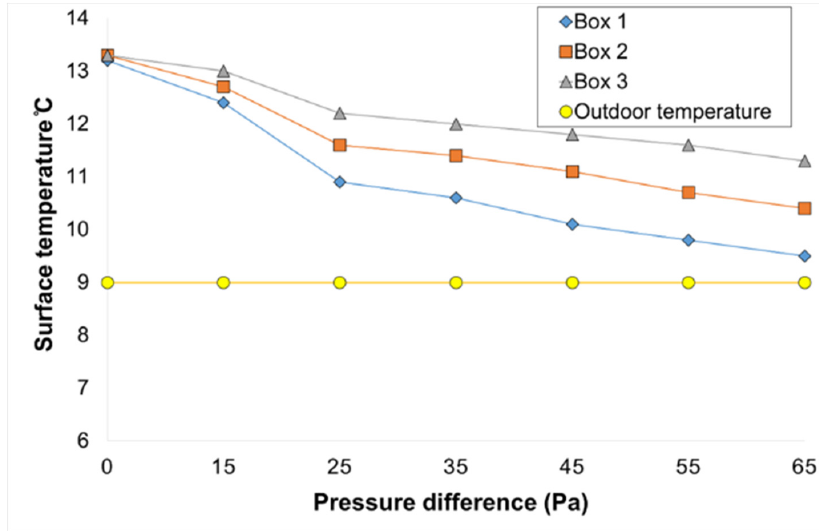
Figure 4. Variation of the surface temperature at the different pressures (Day 1).